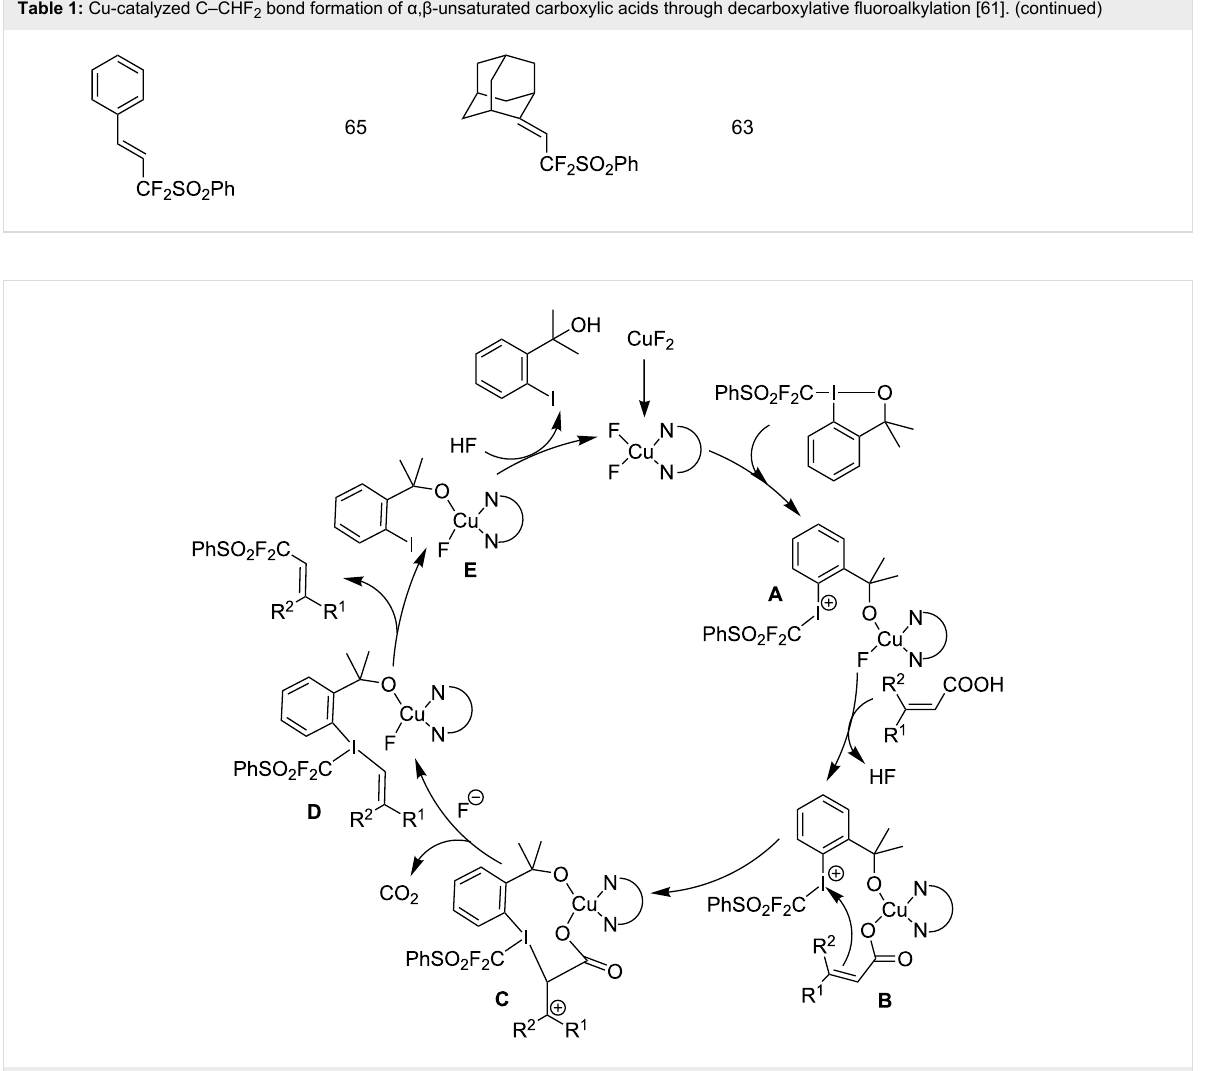
Figure 1: Mechanism of the Cu-catalyzed C–CHF 2 bond formation of α , β -unsaturated carboxylic acids through decarboxylative fluoroalkylation